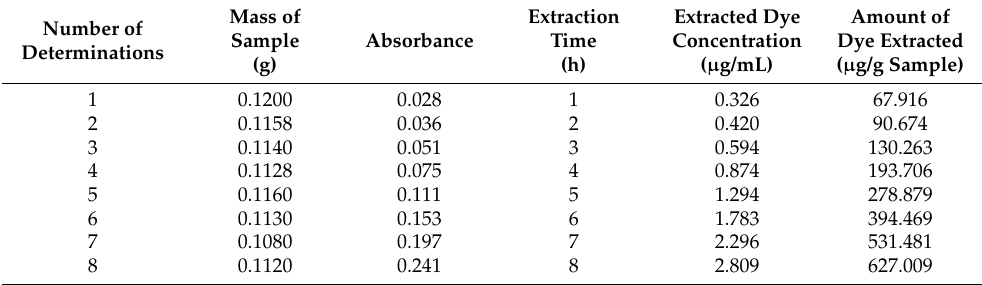
Table 6. Dependence of absorbents on extraction time and 5% concentration of dye extracted from fiber in a neutral